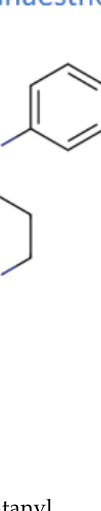
Figure 2. Chemical structure of the drugs propofol and fentanyl.